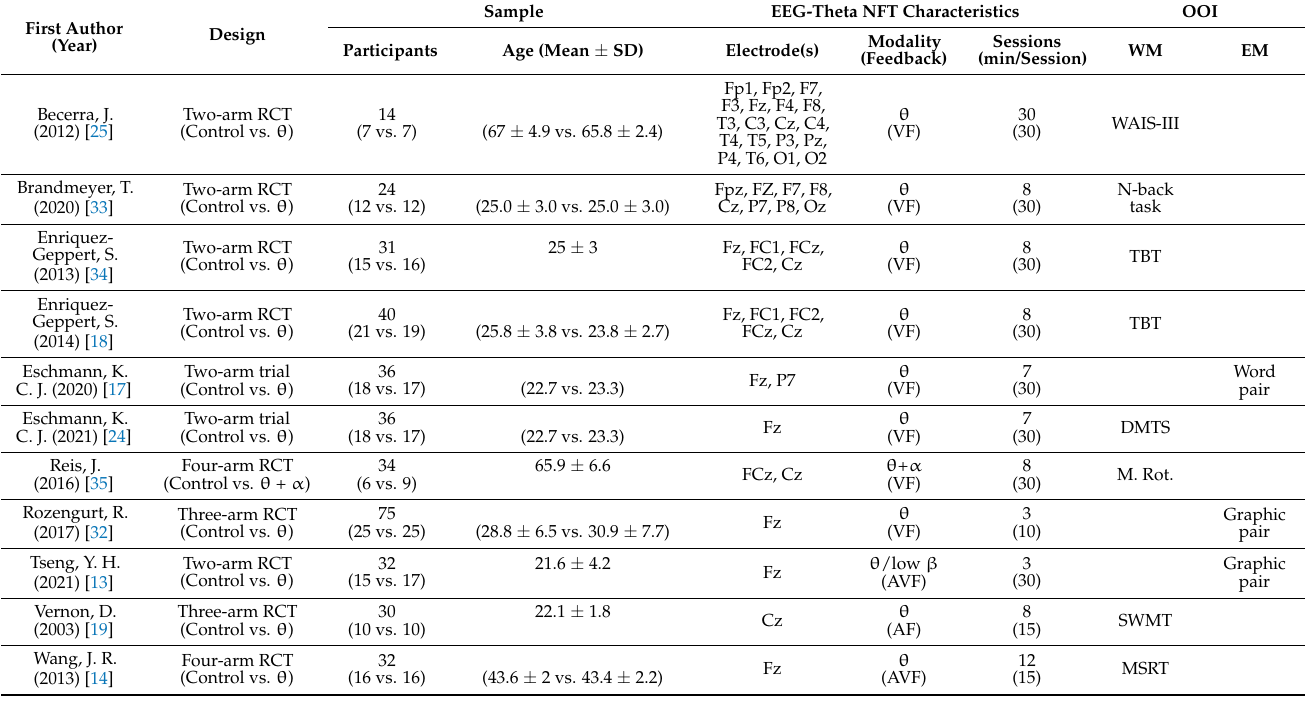
Table 1. Characteristics of studies included in the